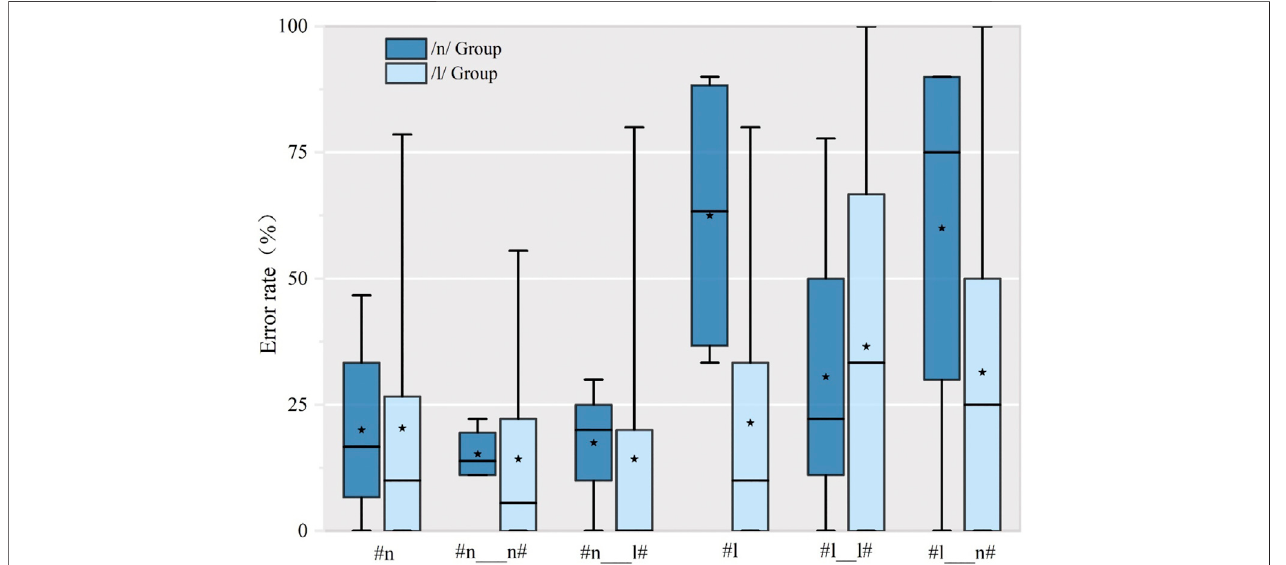
Frontiers in Communication |